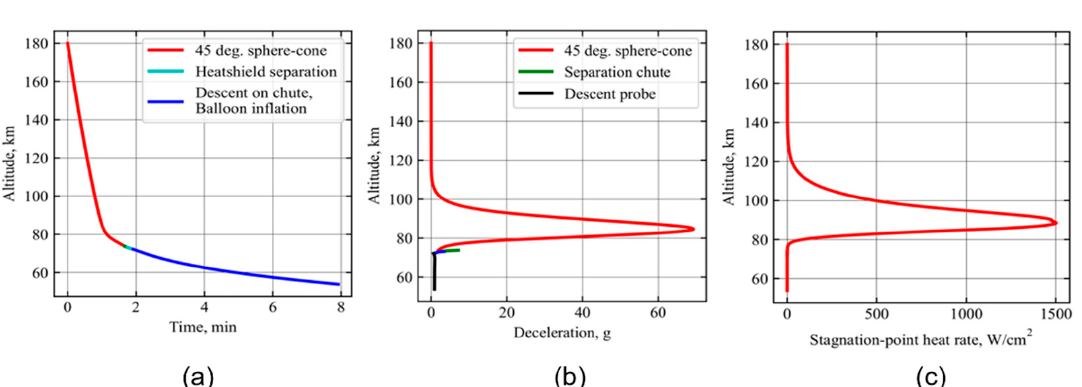
Table 2. Timeline of the entry, descent, and inflation operations.